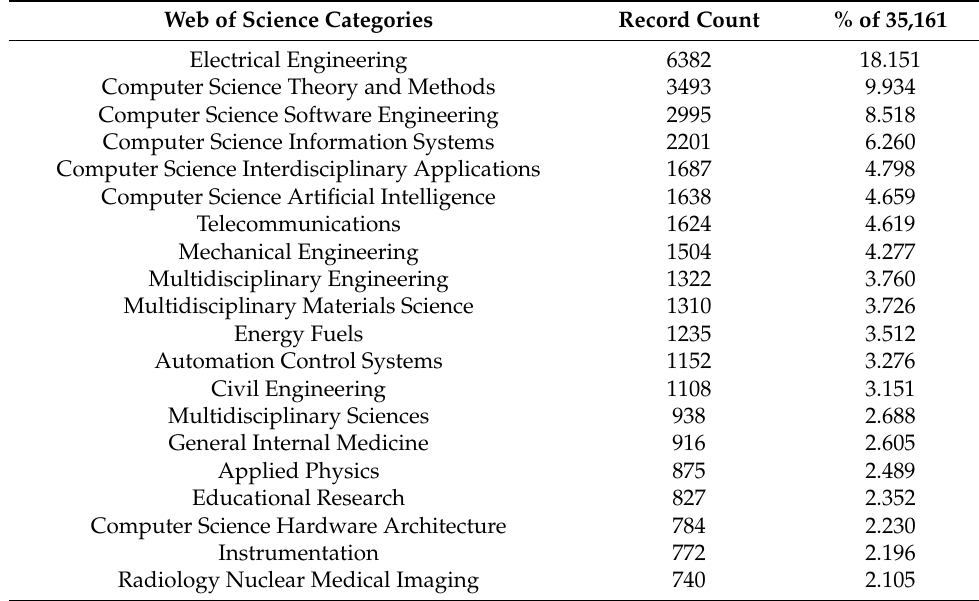
Table 5. Top 20 WoS Categories based on record count of publications